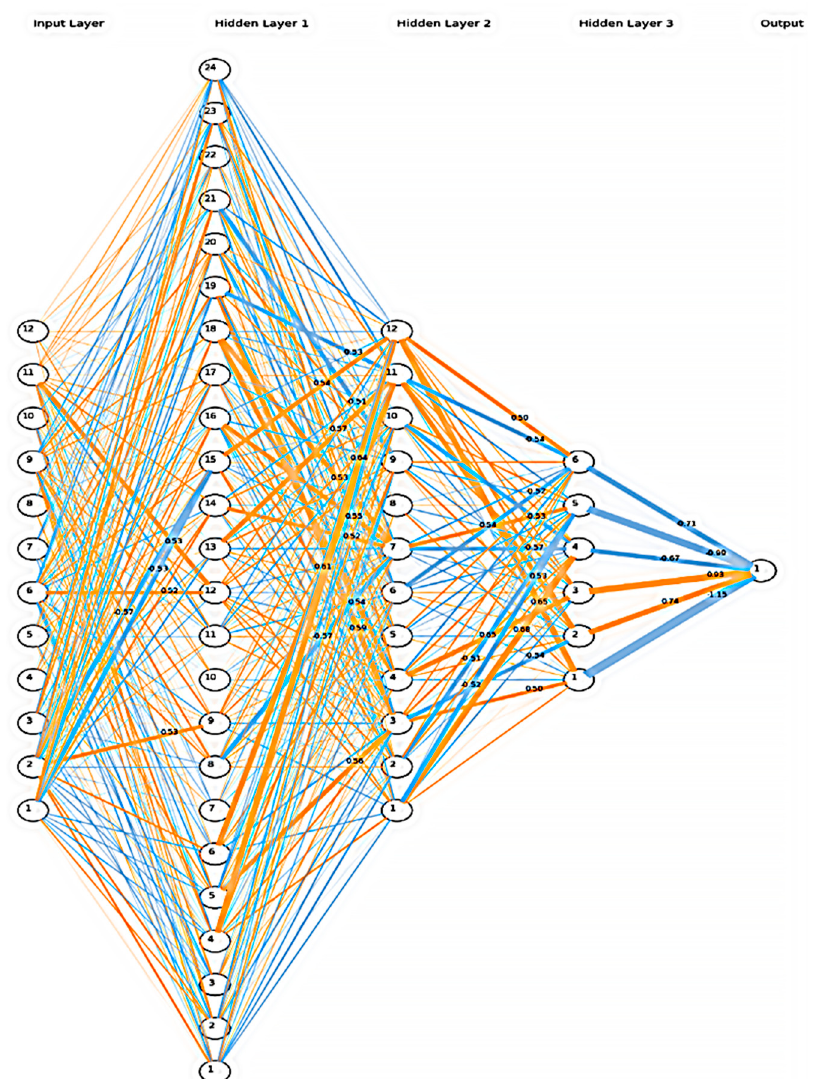
Figure 4. Visualization of the deep learning model. The neurons represented by the small circles are numbered from the bottom to top on each layer in ascending order. The first layer is the input layer with the elasticity values. The remaining four processing layers (three hidden and one output) are described in Table 1. Activation weights are marked with a thicker line.